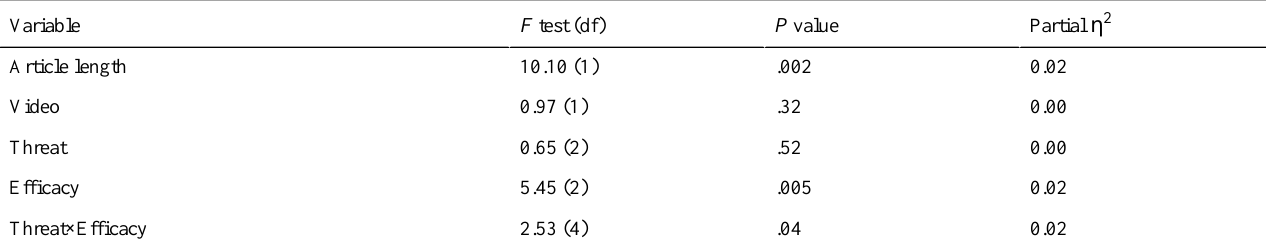
Table 4. Threat×efficacy factorial analysis of variance for intention to the number of likes.